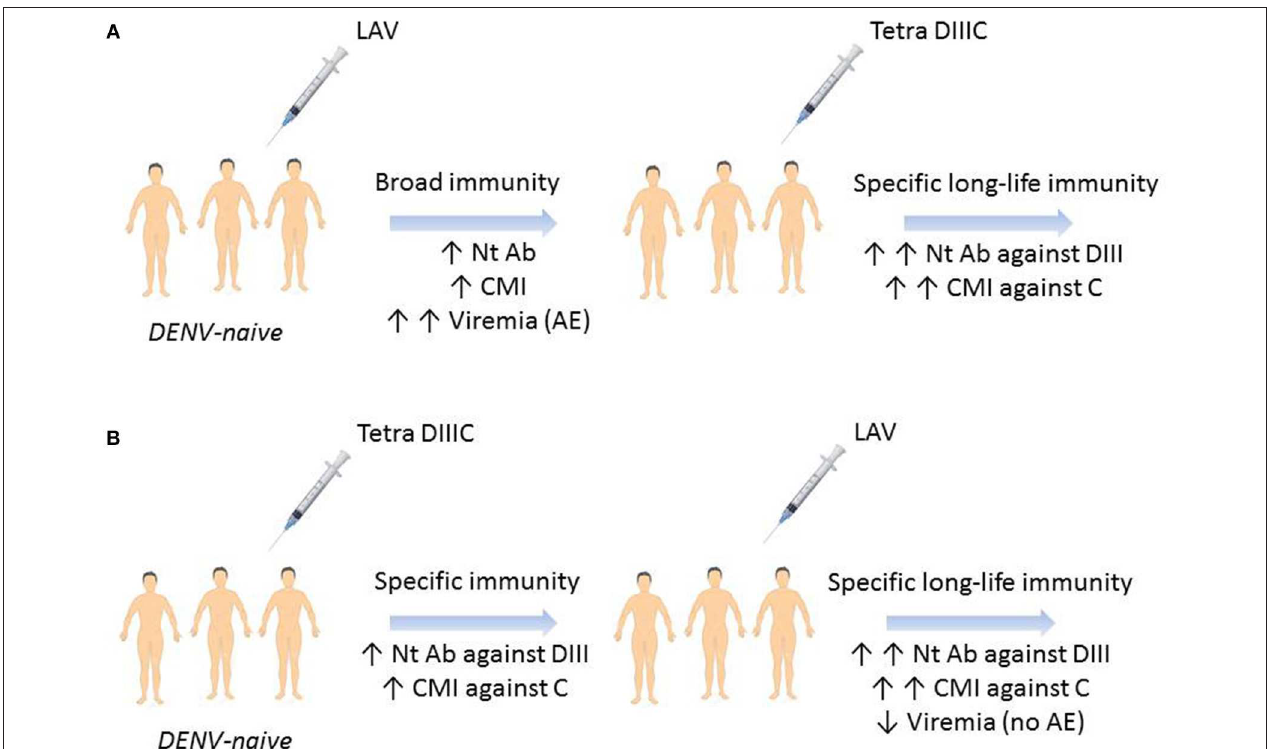
FIGURE 1 | Hypothetical prime-boost immunization regimens outcome for a dengue vaccine. (A) DENV-naïve individual immunization with a live-attenuated vaccine will generate humoral and cellular immune responses against all the viral antigens and viremia days with likely adverse events. Boosting with Tetra DIIIC subunit vaccine will stimulate memory B and T cells specific to domain III and capsid protein. (B) Tetra DIIIC priming will induce humoral and cellular immune responses against domain III and capsid protein which will control LAVT-booster viremia without adverse events. LAVT, live-attenuated tetravalent vaccine; Nt Ab, neutralizing antibodies; CMI, cell-mediated immunity; DIII, domain III of DENV-envelope protein; C, DENV-capsid protein; AE, adverse events.